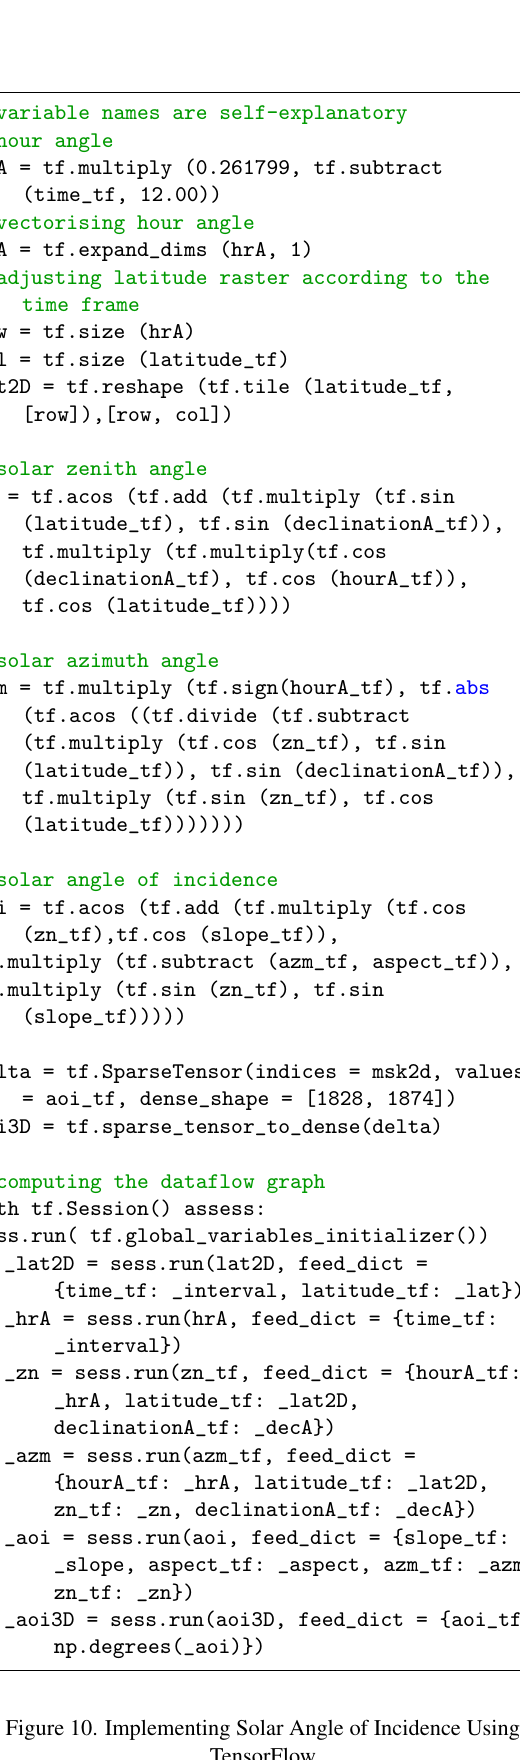
Figure 10. Implementing Solar Angle of Incidence Using